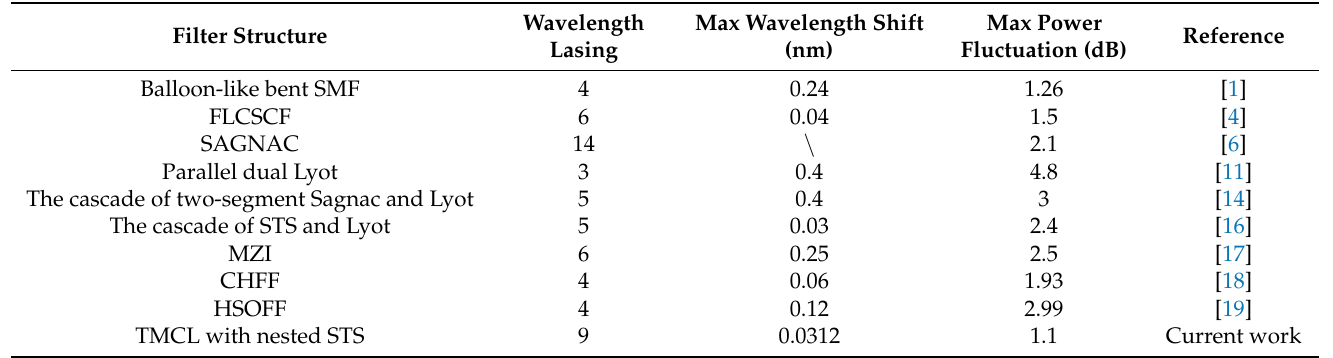
Table 1. Experimental results of stability of MWEDFL based on other